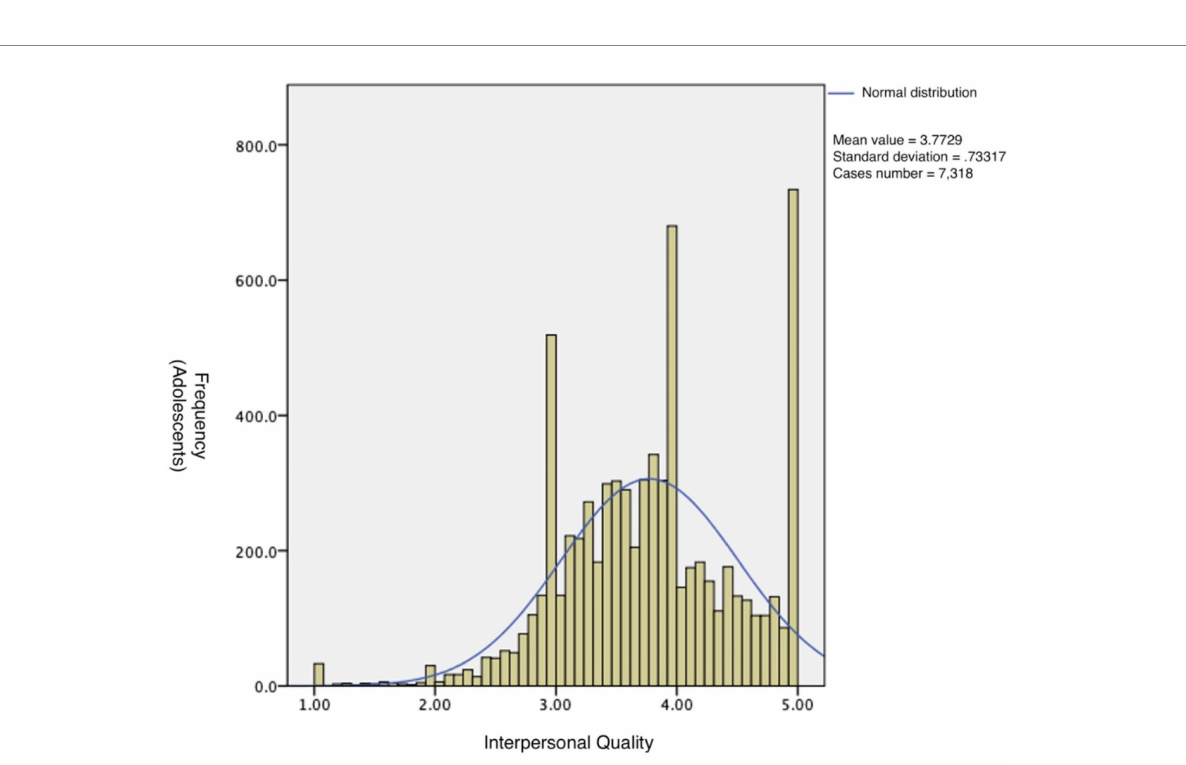
FIGURE 2 Interpersonal quality of Chinese adolescents. Horizontal coordinates describe the frequency of adolescents. And, the vertical coordinates describe the interpersonal quality.